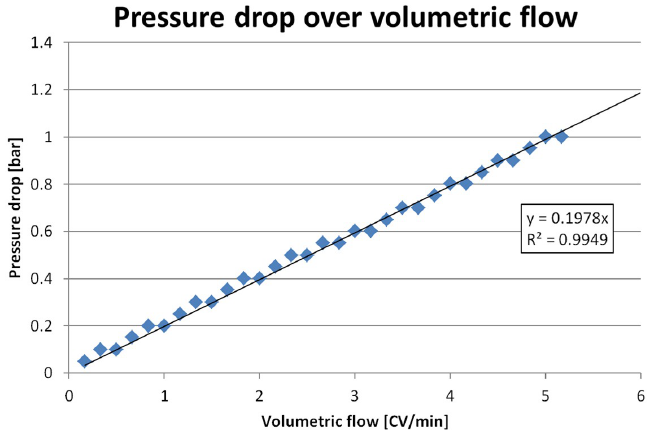
Figure 12. Experimental determination of the pressure drop of one module depending on the volumetric flow. volumetric